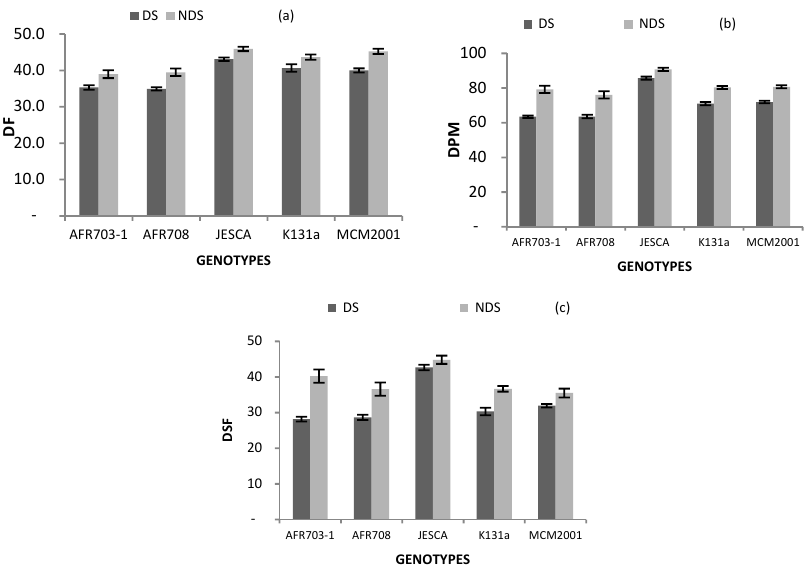
Figure 2. Interaction between genotypes and drought conditions on ( a ) DF; ( b ) DPM and ( c ) DSF. (Bars over the mean indicate standard error). DF: 50% days to flower, DPM: Days to physiological maturity, DSF: Days to seed fill, DS: Drought stress and NDS: Non-drought stress.